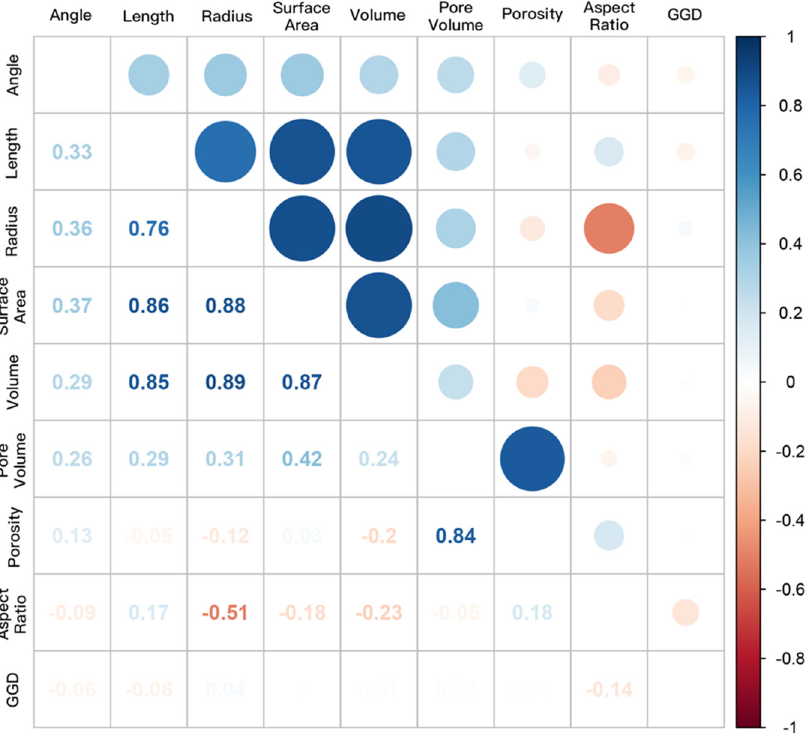
Figure 27. Correlation matrix of wheat phenotypic traits. The upper triangle is the graphical representation, and the lower triangle is the corresponding correlation coefficient.